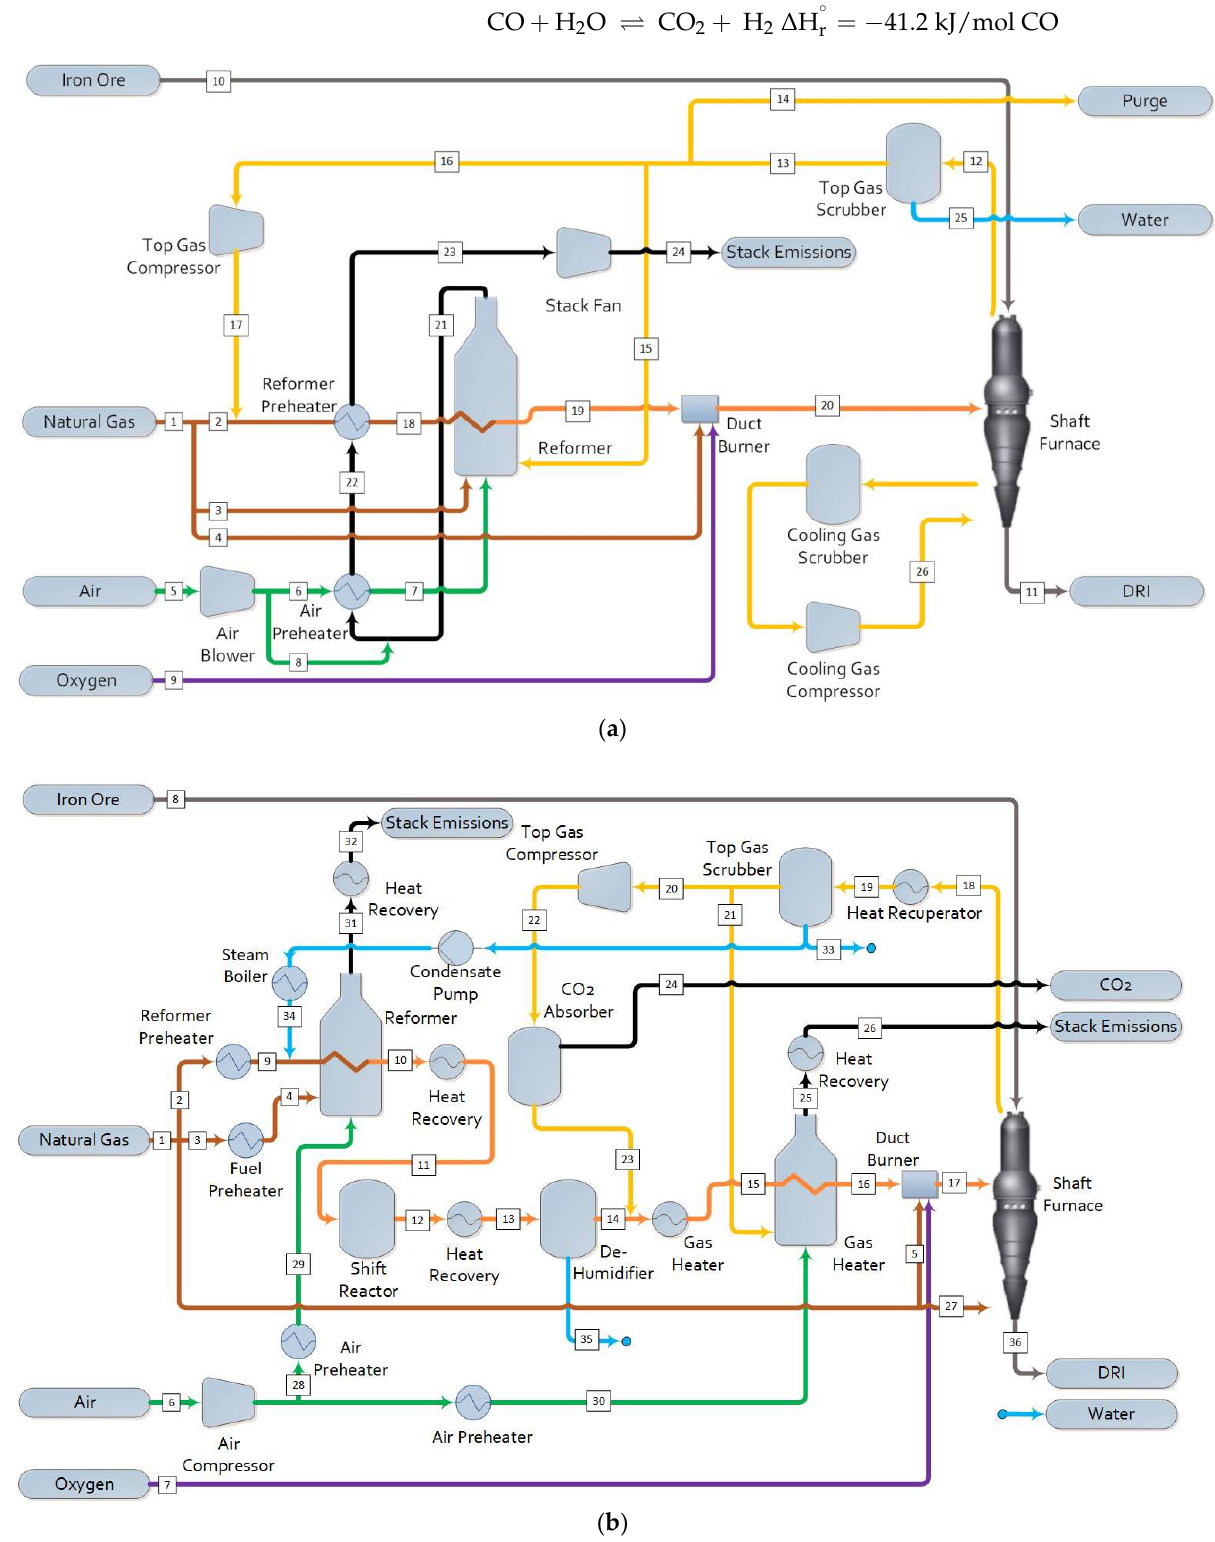
Figure 1. Simplified process configurations for ( a ) a Midrex process and ( b ) an Energiron III process. For ease of viewing, not all heat exchangers or heat integration are shown. Stream properties are defined in the Supplementary Materials (Tables S1 and S2).